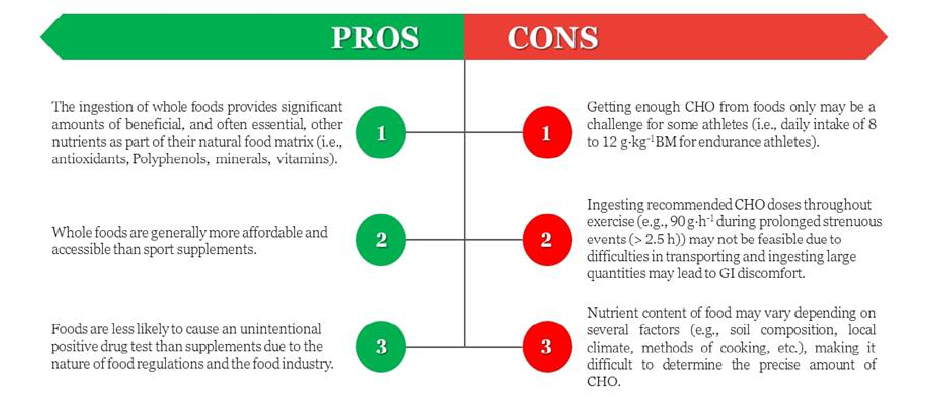
Figure 4. Some pros and cons of a food-first approach to carbohydrate supplementation for endur- ance exercise.